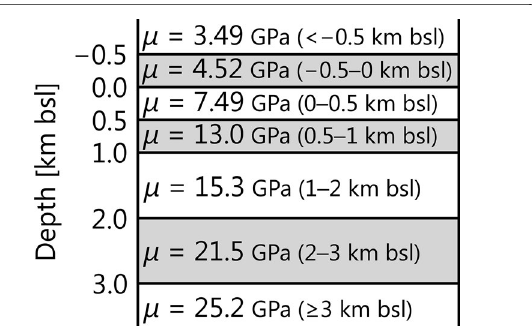
Fig. 6 One-dimensional structure of modulus of rigidity applied to the FEM